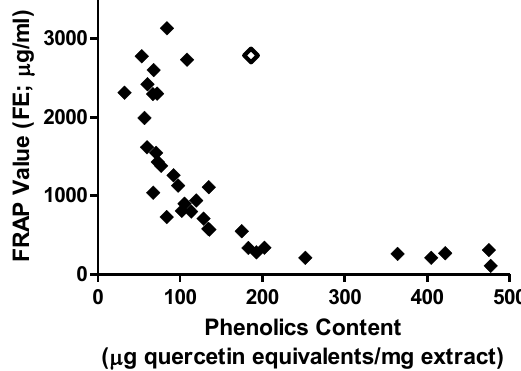
Figure 2. Relation between FRAP value (as FE in μg/mL) and TPC (as μg quercetin equivalents/mg extract) for the 36 plant extracts indicated in Table 1 with FE value less than 4000 μg/mL.